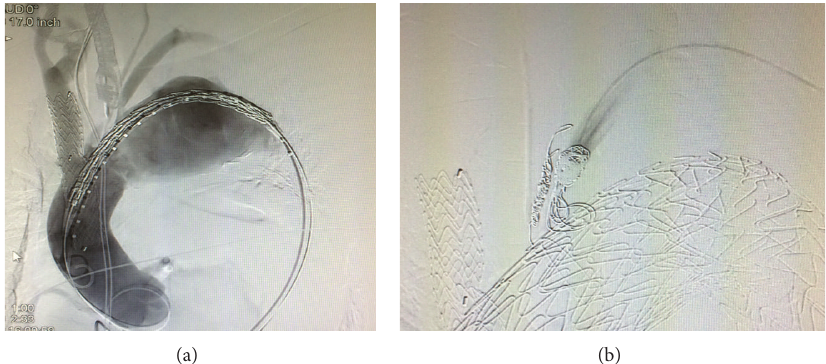
Figure 2: Contrast images taken during surgery. (a) After an indwelling chimney graft was placed from the brachiocephalic artery into the ascending aorta, an indwelling C-TAG was placed from the ascending aorta into the distal aortic arch. (b) After an indwelling C-TAG was placed, the left subclavian artery was coil-embolized. The findings confirmed that endoleaks from the left subclavian artery were fully controlled.